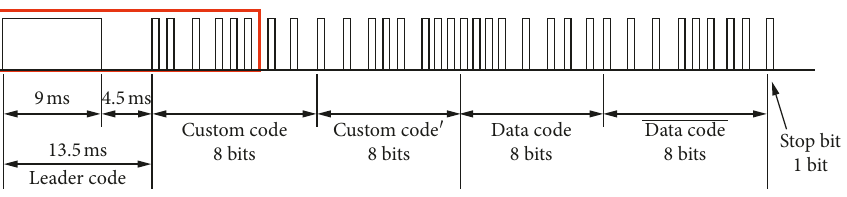
Figure 1: IR signal protocol by NEC.